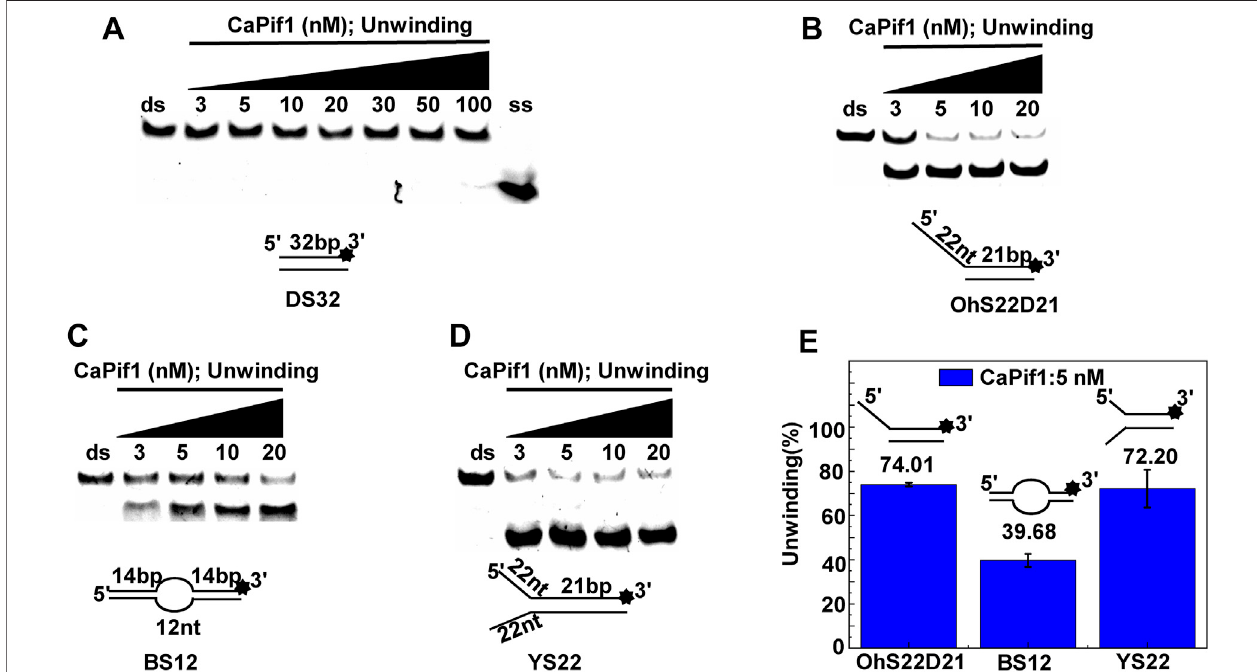
FIGURE 2 | Unwinding preference of CaPif1. Unwinding characteristics of CaPif1 using various DNA substrates: (A) blunt end dsDNA, (B) 5 ′ -overhanged, (C) Bubble, (D) Y-structure. (A – D) The experiments were performed using a series of double-stranded DNA substrates (shown in Table 1 ), fi xed at 10 nM, and CaPif1 graduallyincreased. Theunwindingreactionwasinitiated byadding 5 mM ATPat 30 ° Cfor10 min. NativePAGE (Acr: Bis (cid:2) 39:1) 12%, 100 V,80 min. The fl uorescence signalswerevisualizedbyaChemiDocMPImagingSystem(Bio-Rad,California,UnitedStates).WecalculatedtheproportionofunwindingDNAat5 nMCaPif1for a clearer analysis by scanning the gray values with Image Lab software (E) (Supplementary Table S1) . All experiments were performed under standard experimental conditions as described in “ Materials and Methods.